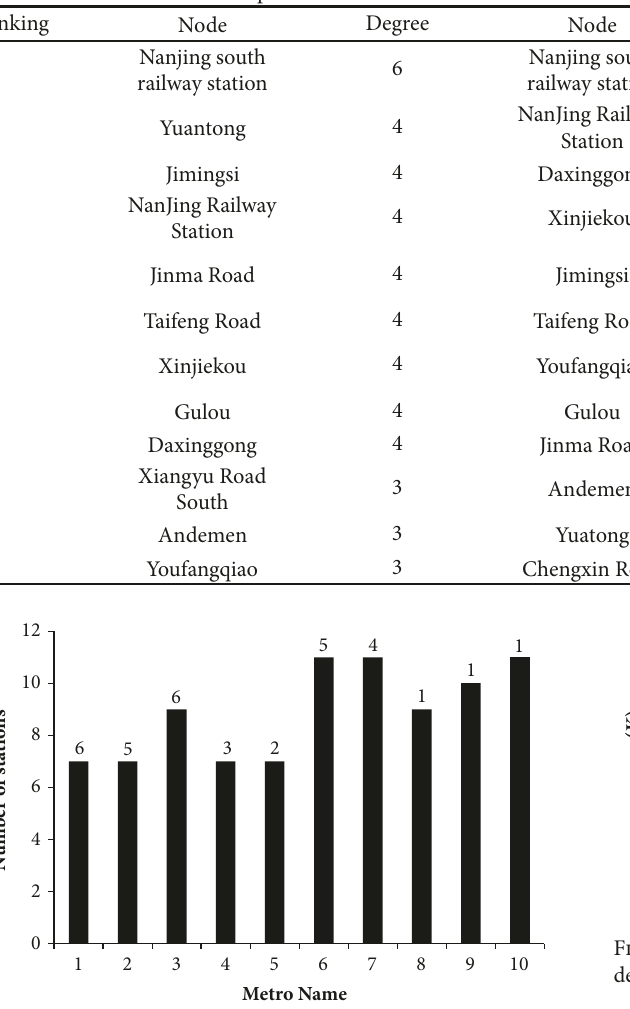
Figure 9: Hyperedge degree distribution of the hypernetwork in Nanjing metro.